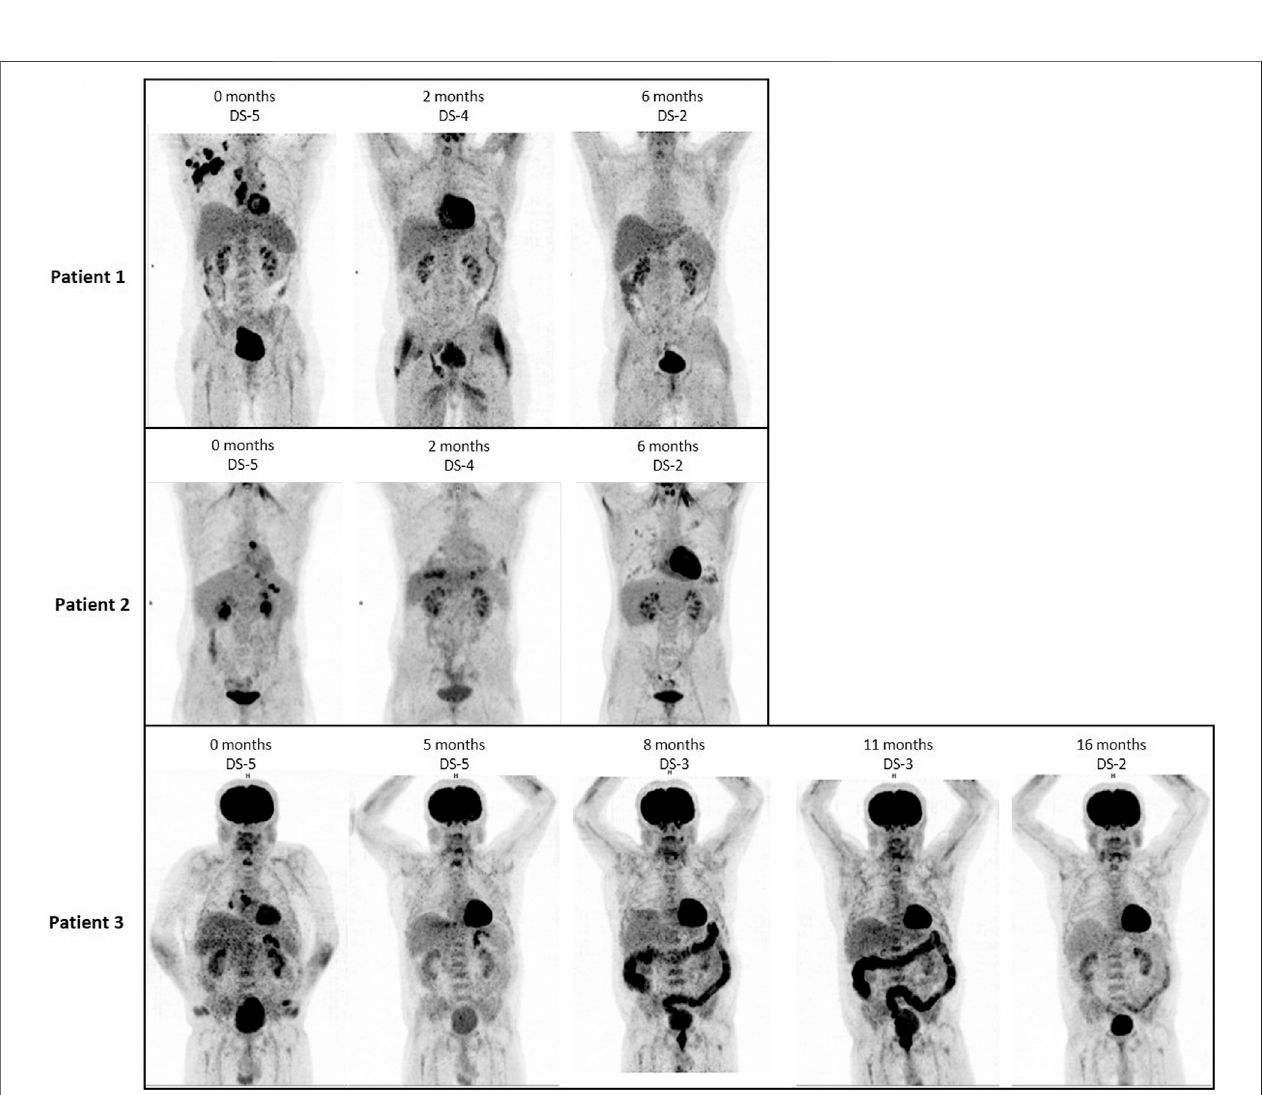
FIGURE1| FDGPET/CTimages(ventralmaximumintensityprojection,MIP)ofpatient1 – 3 atthetimeofMEPEDtreatment,includingDeauvilleScore(DS)analysis. AllthreepatientsshowadecreaseinDSatrestagingasasignofresponse.Inpatient2,therapy-associatedbipulmonaryin fl ammationisfound6 monthsafterinitiationof